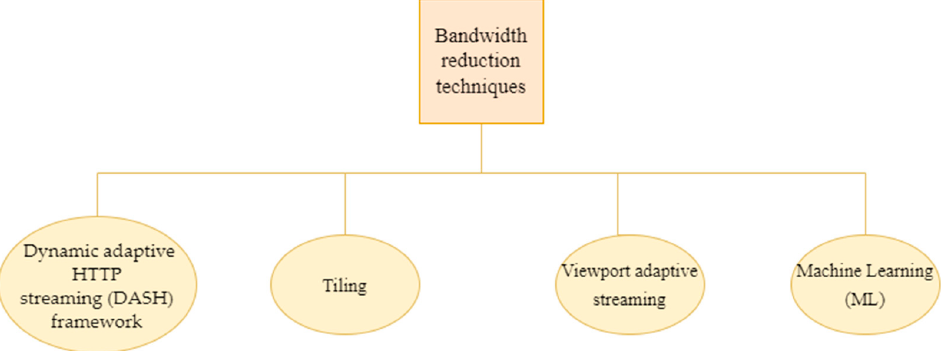
Figure 2. Bandwidth reduction